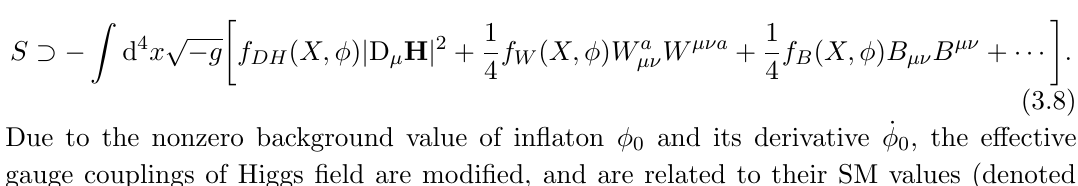
Figure 3 . The quantum corrected Higgs mass M of tree level mass M H 0 . The three curves from bottom to top correspond to (cid:21) = (0 : 01 ; 0 : 1 ; 0 : 5),